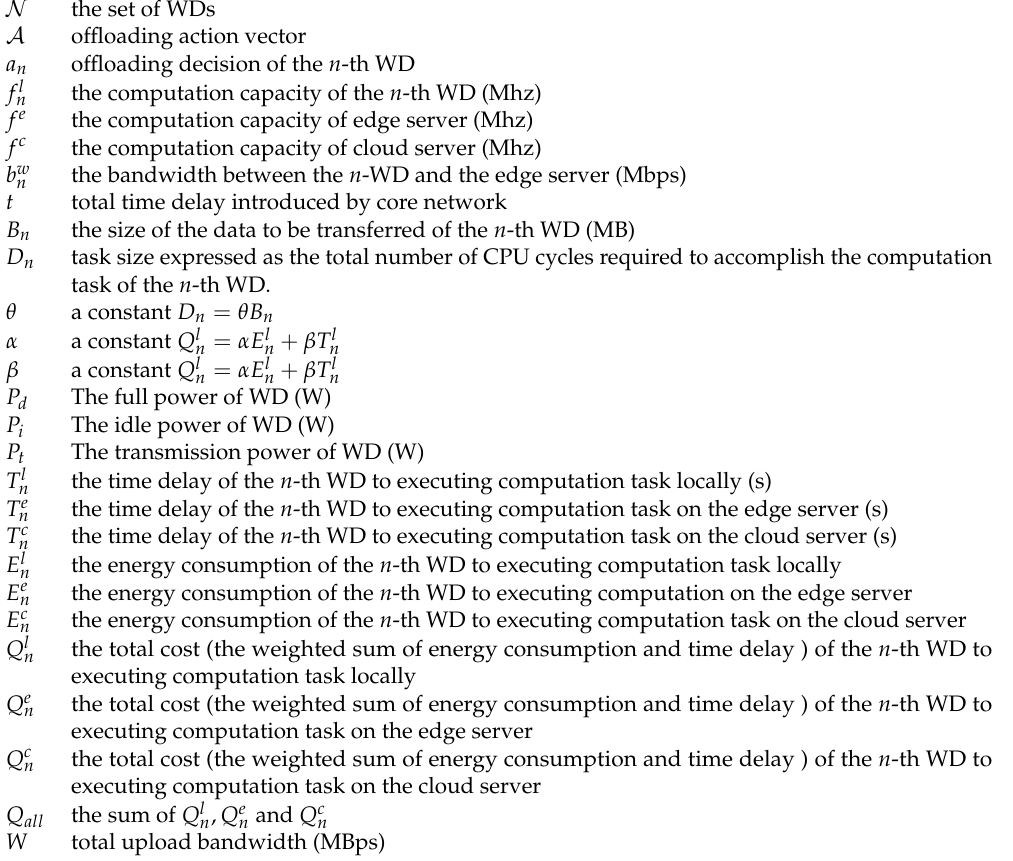
Table 1. Notations used in this